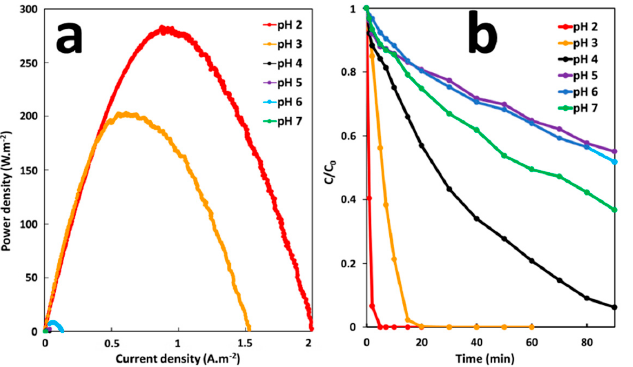
Figure 7. ( a ) Power curves of the GF process obtained at different pH and ( b ) Effect of pH on the degradation of MG dye during the GF process. degradation of MG dye during the GF